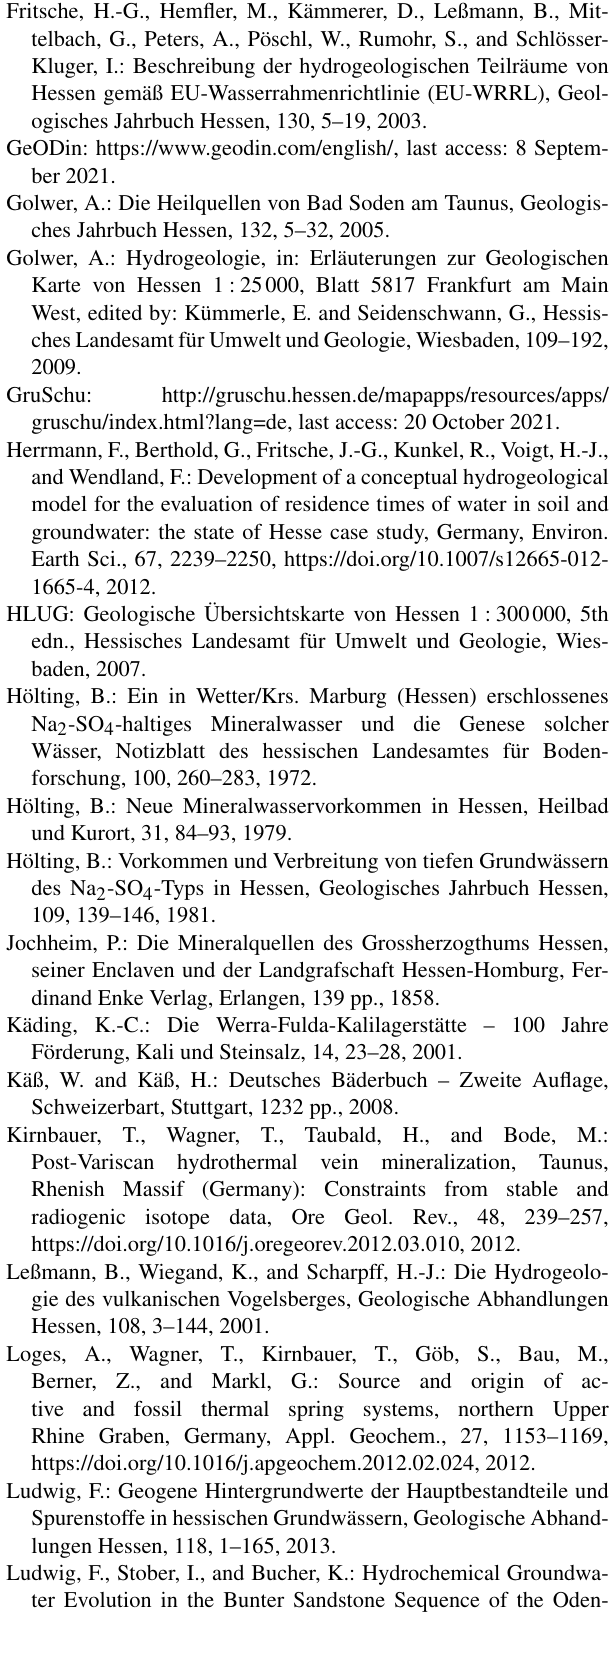
DSK: Stratigraphic Table of Germany 2016, 2nd edn., German Stratigraphic Commission, Potsdam, available at: http://www. stratigraphie.de/std/Bilder/5_2.pdf (last access: 26